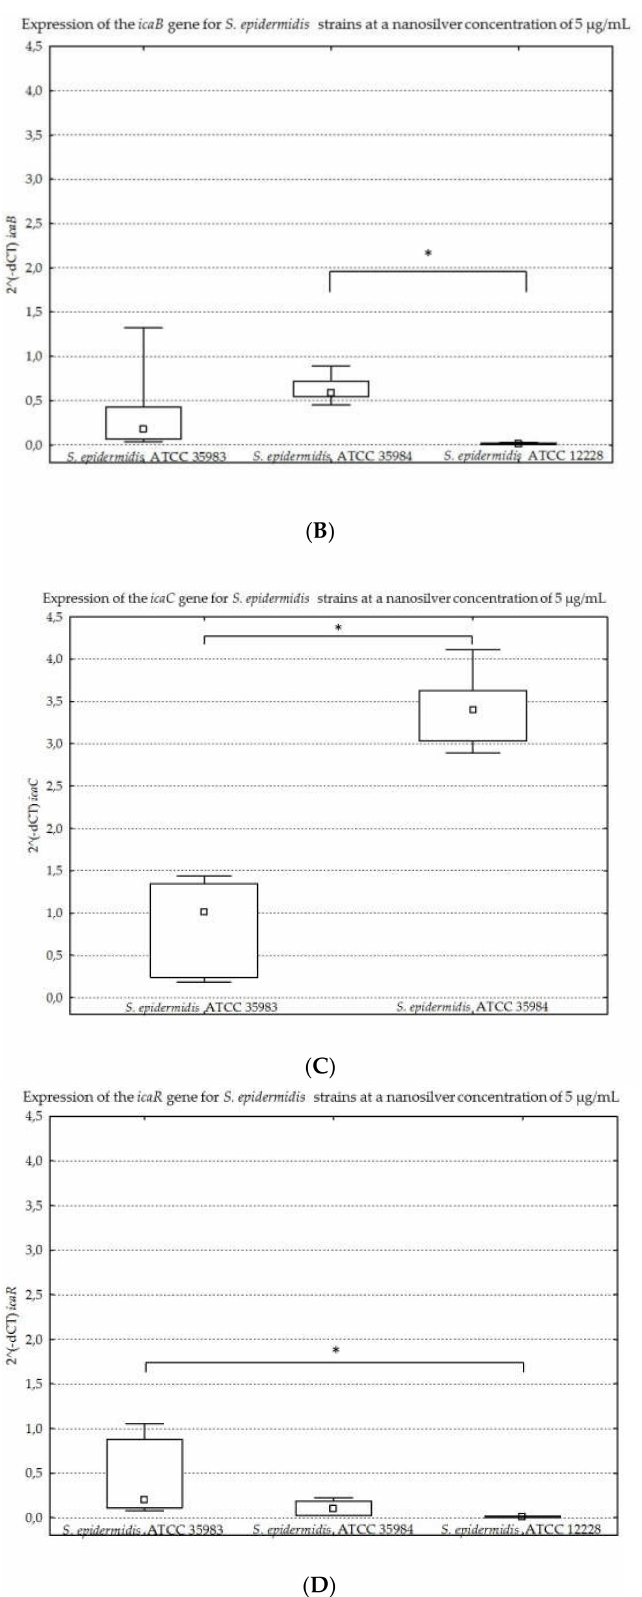
Figure 11. ( A – D ). Gene expression ( icaA , icaB , icaC , icaR ) depending on the strain of S. epidermidis at a nanosilver concentration of 5 µ g/mL, presented as medians and quartiles (Q1 and Q3). Statistical significance: * p <